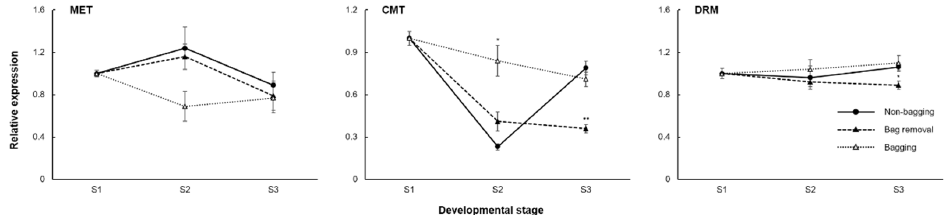
Figure 6. Quantitative real-time PCR analysis of methylation-related genes in ‘Fuji’ apples cultivated under different bagging treatments: no bagging (control; labeled as “non-bagging”), bagging followed by bag removal (labeled as “bag removal”), and bagging with no bag removal (labeled as “bagging”). Apples were harvested at three time points: before paper-bagging (S1, DAFB 97) and then 1 and 4 weeks after bag removal (S2, DAFB 169 and S3, DAFB 191). The x -axis and y -axis indicate the time of harvesting and relative expression, respectively. For each gene, the expression level at S1 was set as 1. Bars represent the standard error of triplicate samples. * and ** indicate significance levels of p < 0.05 and p < 0.01, respectively. DAFB, days after full